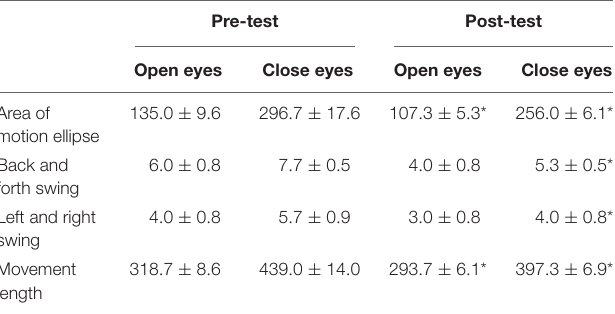
TABLE 2 | Pre-test and post-test of static balance parameters (unit: